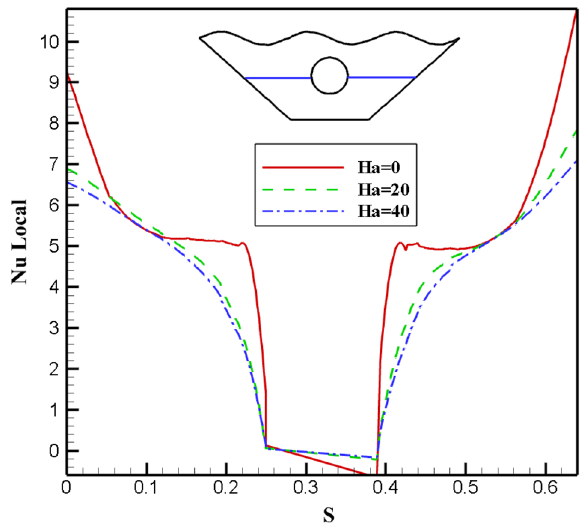
Figure 15. Local Nu number plot for differentHartman numbers (Ha).